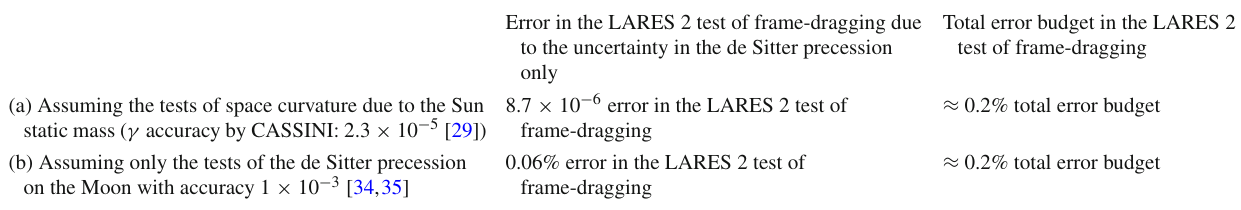
Table 1 The error introduced by the de Sitter precession in the test of frame-dragging using LARES 2 and its impact in the total error